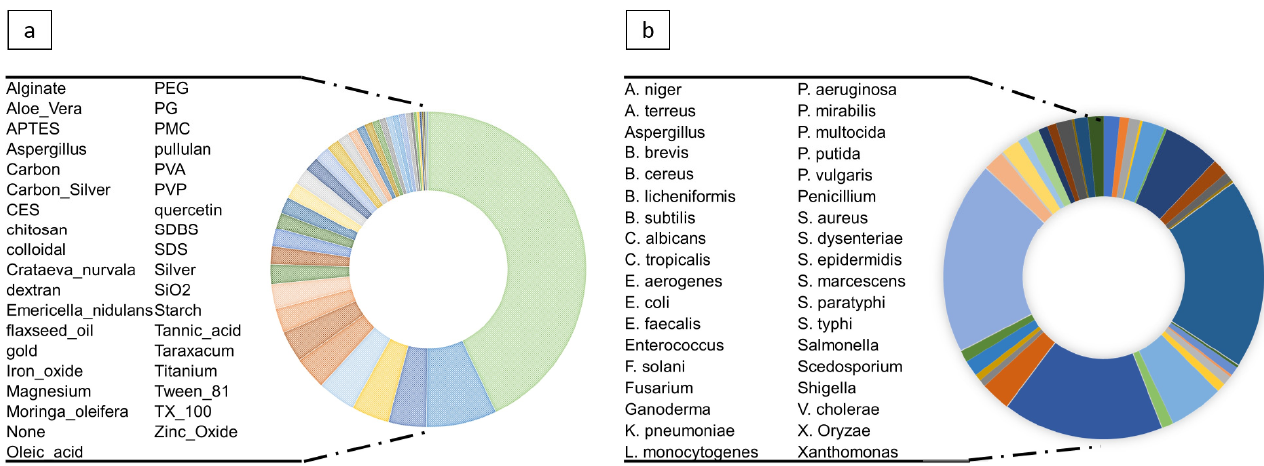
Figure 3. Coating information of NP, the coating variables are all 57% and the un-coated is 43% ( a ). Species of several investigated foodborne and environmental bacterium ( b ).